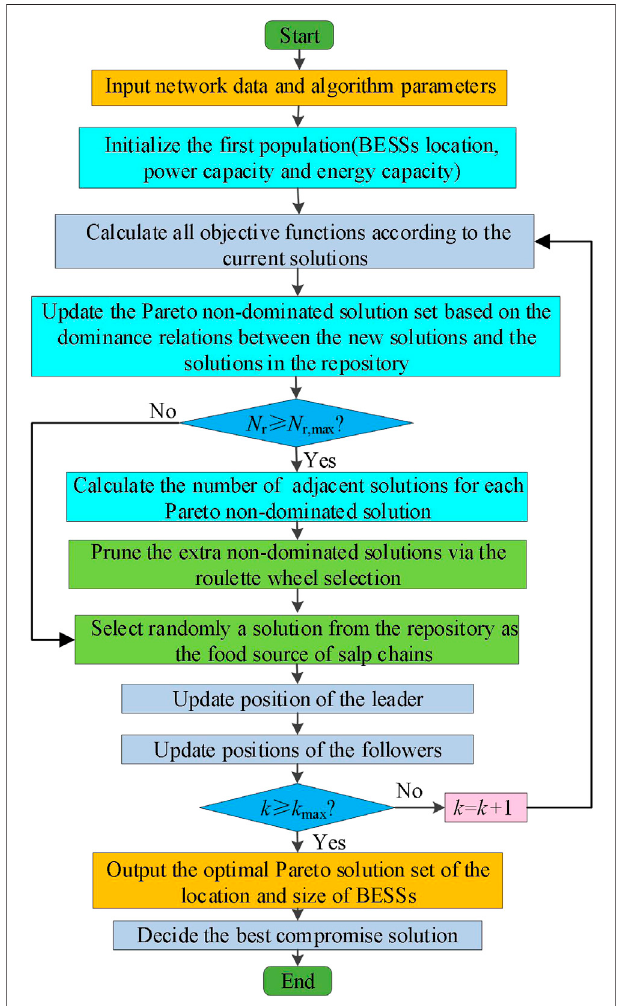
FIGURE 3 | The fl owchart of MMSSA for the optimal locating and sizing of BESSs.